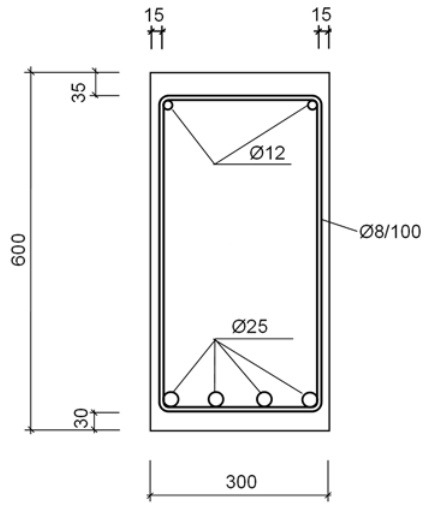
Figure 4. Beam cross-section (mm).